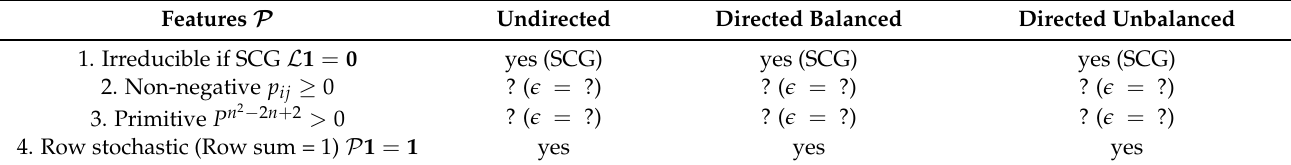
Table 2. Main properties of P for the different graph